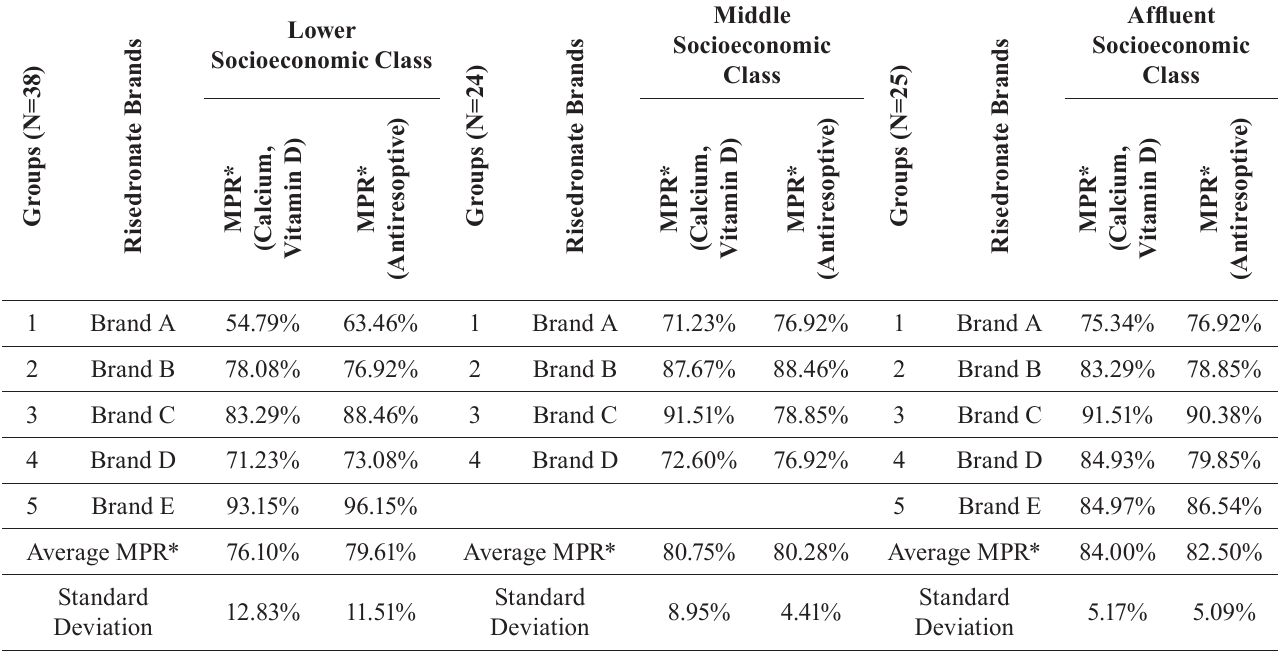
TABLE I - M PR of Riserdronate Brands, Calcium, Vitamin D in different Socioeconomic Classes